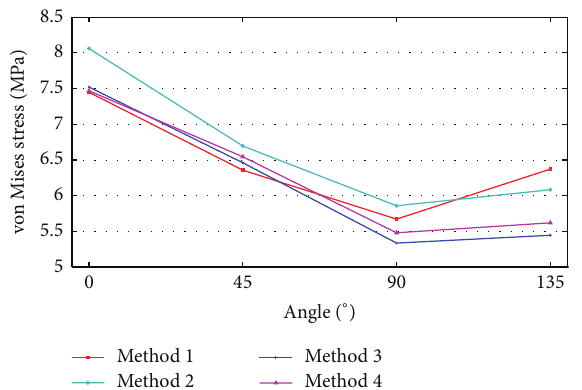
Figure 11: Changes in the von Mises stress of models at different